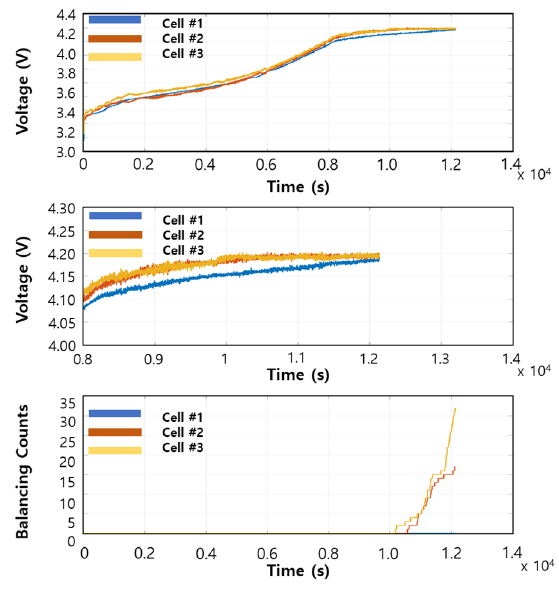
Table 6. Balancing parameters from module #1.